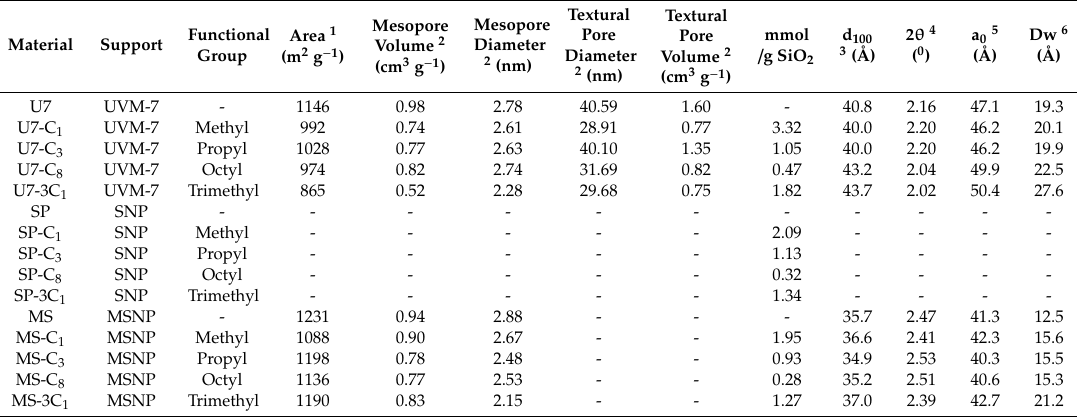
Table 1. Textural properties and organic content of the silica based